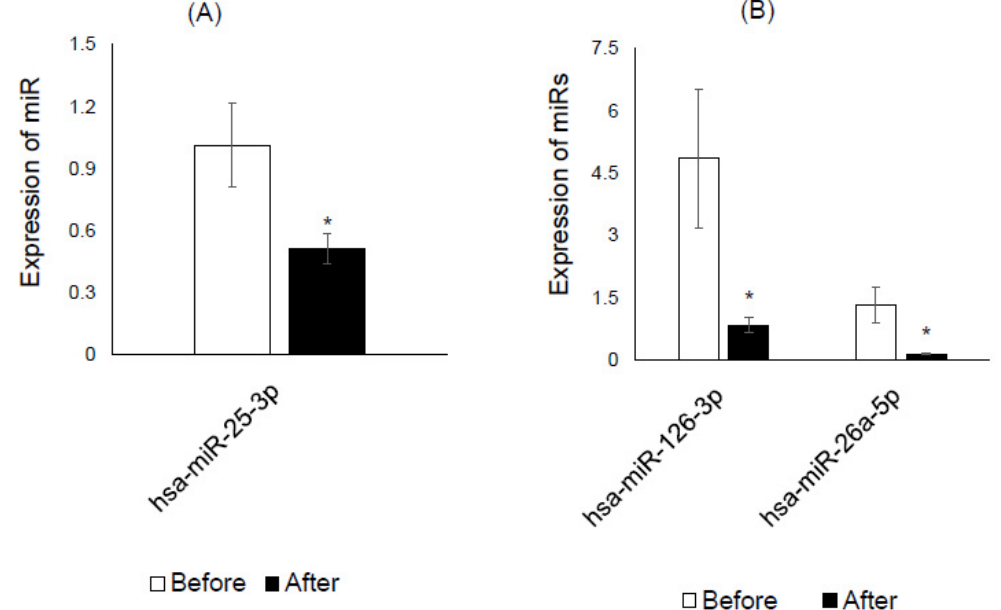
Figure 1. Validation of plasma miRs by RT-qPCR. ( A ) Hsa-miR-25-3p was down-regulated in the plasma of the control diet group. ( B ) Hsa-miR-126-3p and hsa-miR-26a-5p were down-regulated in the plasma of the K-diet group. White and black columns represent miR expression before and after the intervention, respectively. * p < 0.05 by paired t -test.